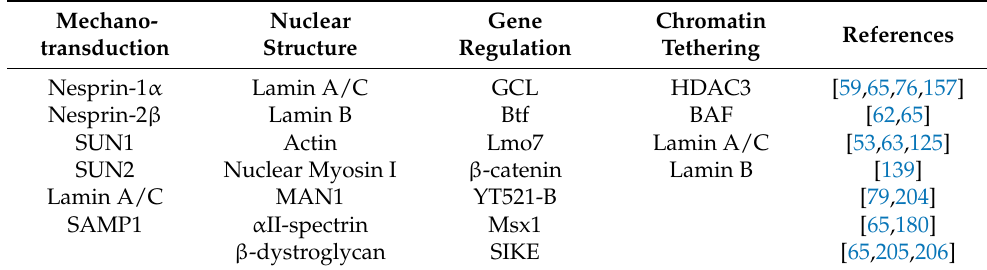
Table 1. Emerin binding partners. Emerin regulates a number of cellular pathways by acting directly or indirectly with key players in these pathways. Reported emerin binding partners are grouped according to their known or proposed